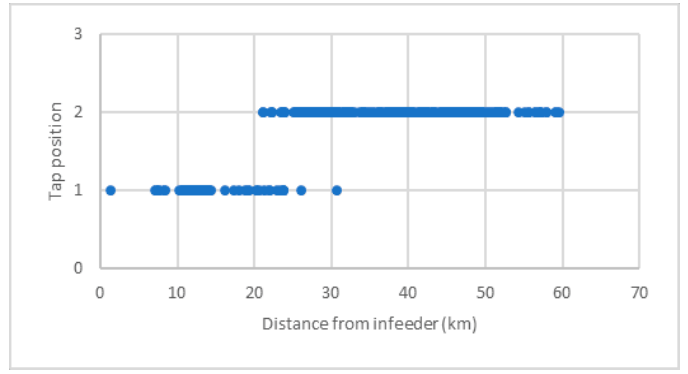
Figure 11. Transformer tap setting against electrical distance from the infeeder for Case 2.1.